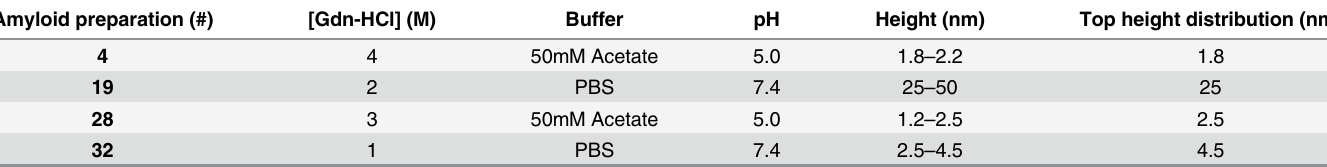
Table 1. Different height of clusters of recMoPrP (23 – 231) aggregates. Amyloid preparation